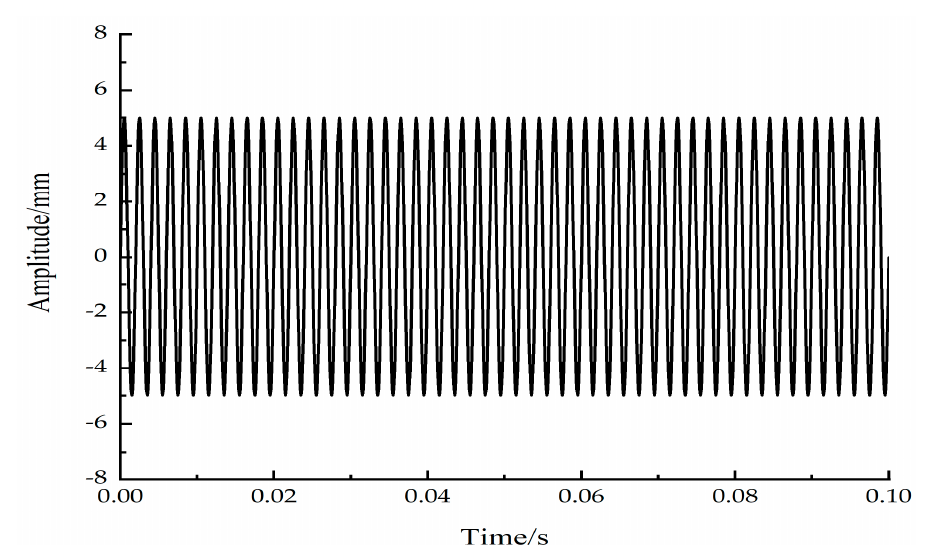
Figure 5. Waveform of the mechanical vibrations.